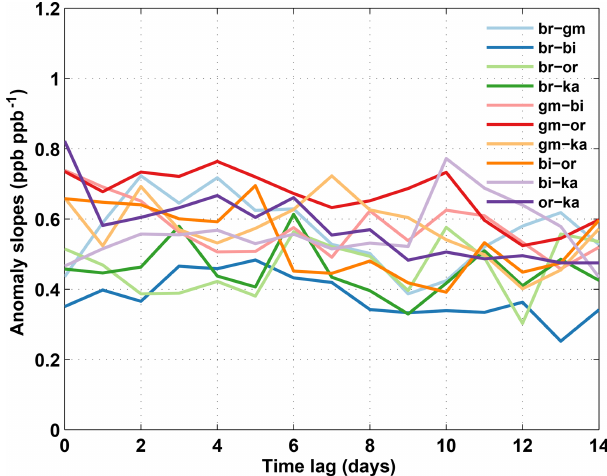
Figure A2. These are the anomaly slopes ( (cid:49) CH 4 /(cid:49) CO) in ppbppb − 1 for each station pair, for the entire time series. The anomalies are computed by subtracting data within the same so- lar zenith angle bin between two TCCON stations. For more detail, see Sect. 2 of the main text. The x axis indicates the number of days separating the measurements. The legend identifiers are as